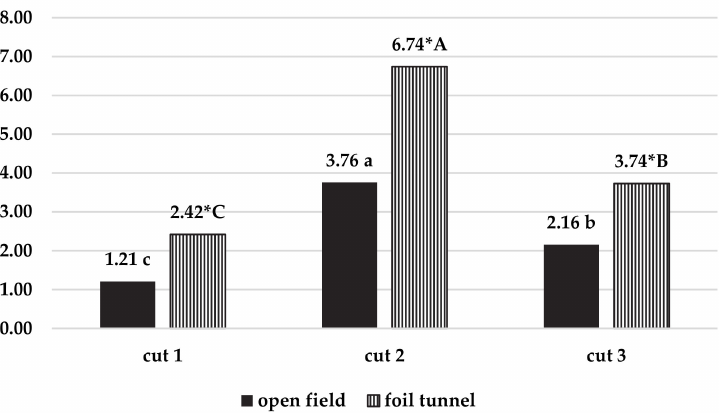
Figure 1. Mass of common thyme herb (kg FW × 10 m 2 ). Tukey test; * p < 0.05; a, b, c are the means marked with small letters (values for following cuts in the open field) differ at p < 0.05; A, B, C are the means marked with capital letters (values for following cuts in the foil tunnel) differ at p < 0.05.